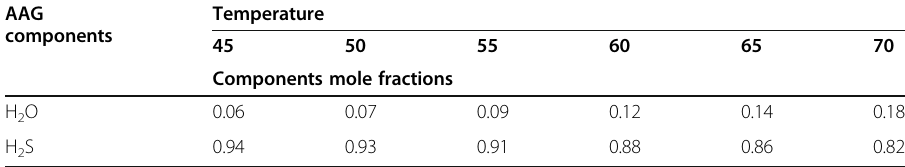
Table 16 AAG composition at different inlet temperatures to SRU AAG